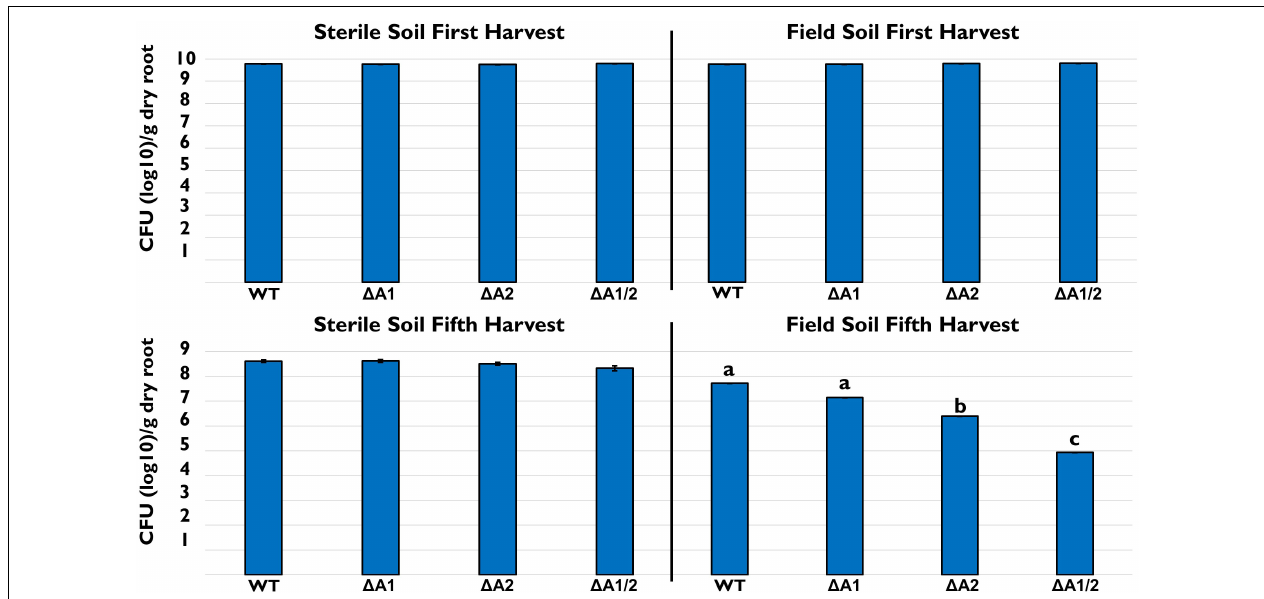
FIGURE 2 | Rhizosphere persistence over repeat harvests. Bacterial populations (log10 CFU/g root dry weight) in sterile and field soil after the first and fifth harvest. Strains tested included 30–84 WT, the single T6SS mutants (cid:49) TssA1 and (cid:49) TssA2, and the double mutant (cid:49) TssA1/2. Data are the mean and standard errors (bars may be too small to see for some treatments) from three replicate experiments ( n = 10/per replicate). Lettering indicates significant differences. Data were analyzed using a one-way ANOVA and Tukey’s tests and significant differences are indicated, p <